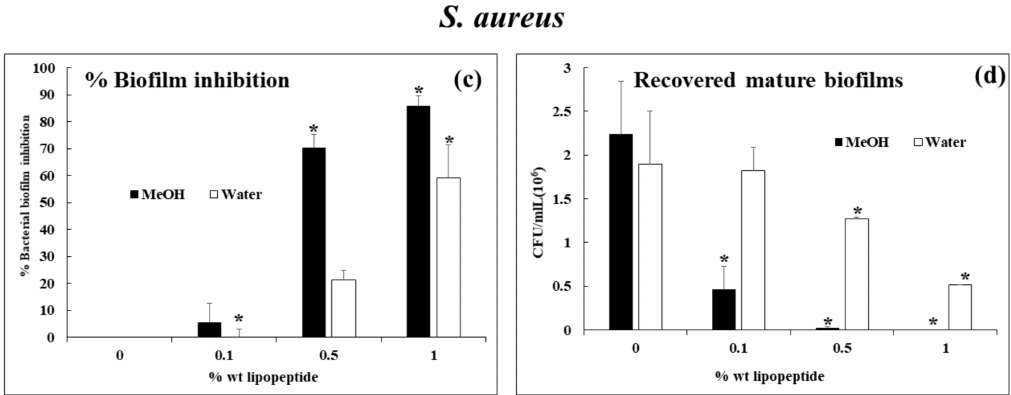
Figure 5. The e ff ect of lipopeptide gels on mature (seven days old) biofilms P. aeruginosa and S. aureus . ( a , c ) represent the percentage of bacterial biofilm mass reduction determined by the optical density of the solubilised crystal violet recovered from the stained biofilm of P. aeruginosa and S. aureus respectively. ( b , d ) are the recovered mature biofilm cells of P. aeruginosa and S. aureus respectively after sonicating the gel samples. Results presented are averaged from two independent experiments done in triplicate * Indicates p <